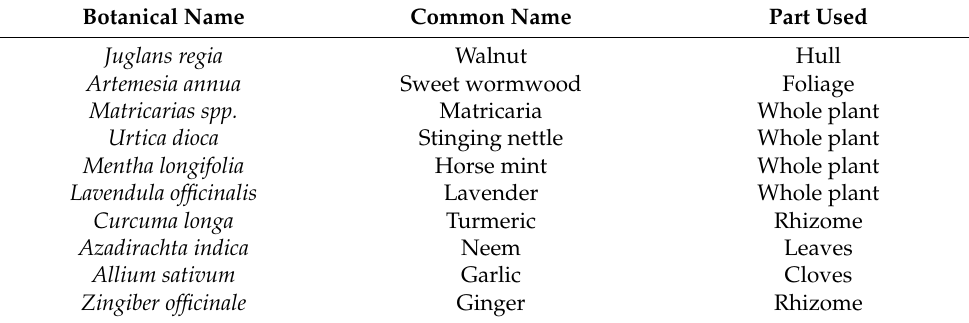
Table 1. List of botanicals evaluated against A. bisporus and T.